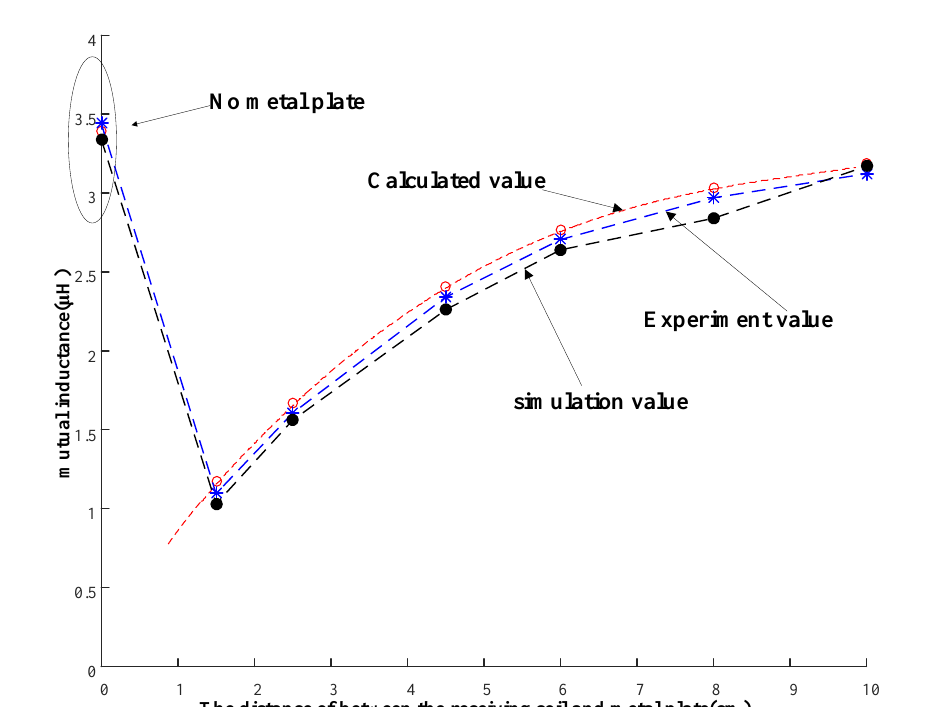
Figure 9. Effect of metal plate’s distance on the mutual inductance between coils.